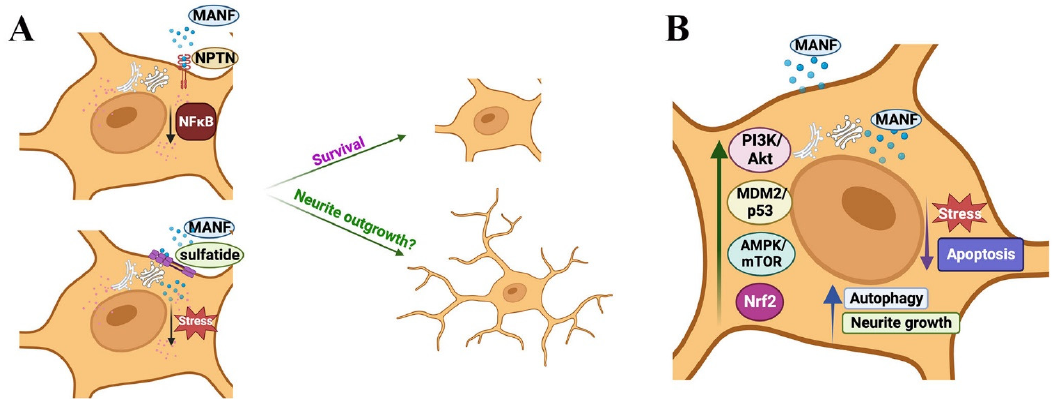
Figure 3. The potential and established mechanisms for MANF’s actions independent of ER stress- UPR axis: ( A ) Extracellular MANF binds to the cell surface: extracellular MANF binds to the lipid sulfatide on the cell surface for cellular entry. MANF also binds to Neuroplastin (NPTN) receptor on the cell surface. MANF’s binding to sulfatide and NPTN and associated signaling promotes cellular survival. Whether MANF promotes neurite outgrowth in a sulfatide or NPTN-dependent manner is unknown. ( B ) MANF promotes cell survival independent of UPR signaling: MANF modulates PI3K/Akt signaling, MDM2/p53 axis, AMPK/mTOR axis, and Nrf2 signaling for its survival, anti-apoptotic, autophagy, and neurite outgrowth promoting actions.